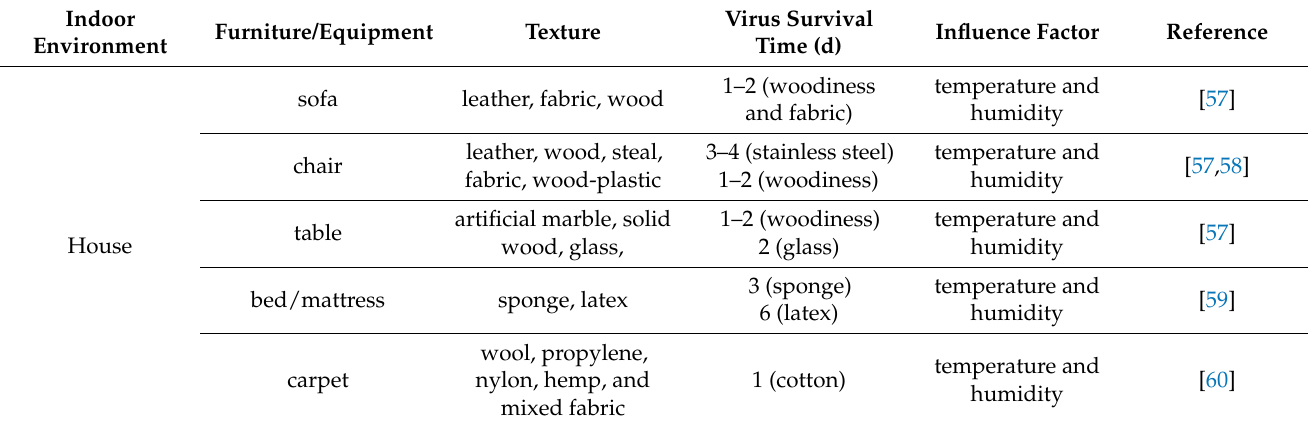
Table 1. The virus survival time (d) on different textures in indoor environment.